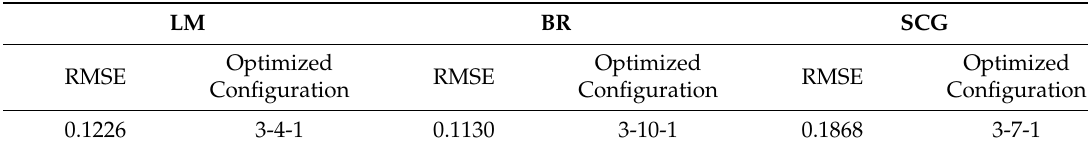
Table 5. Performance comparison of training algorithms.